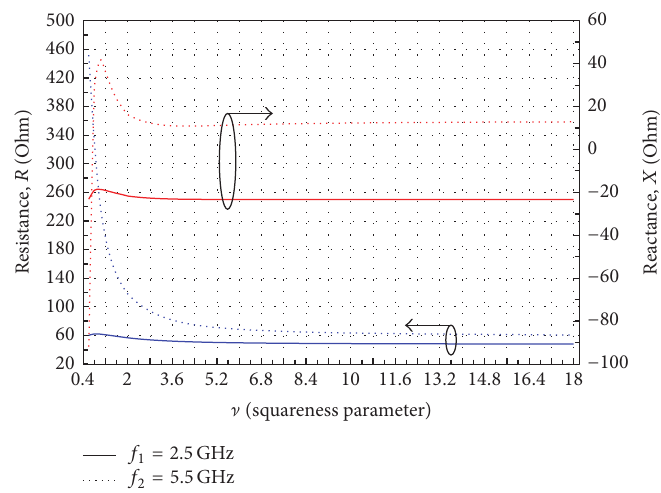
Figure 4: Impedance characteristics versus typical values of ] .